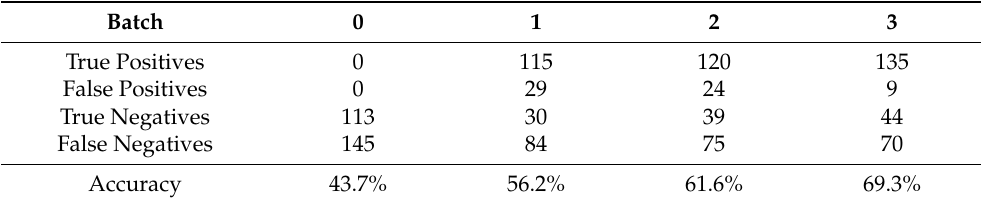
Table 4. Classifier’s accuracy without hyperparameters’ optimisation over training batches through the DIDComm protocol.